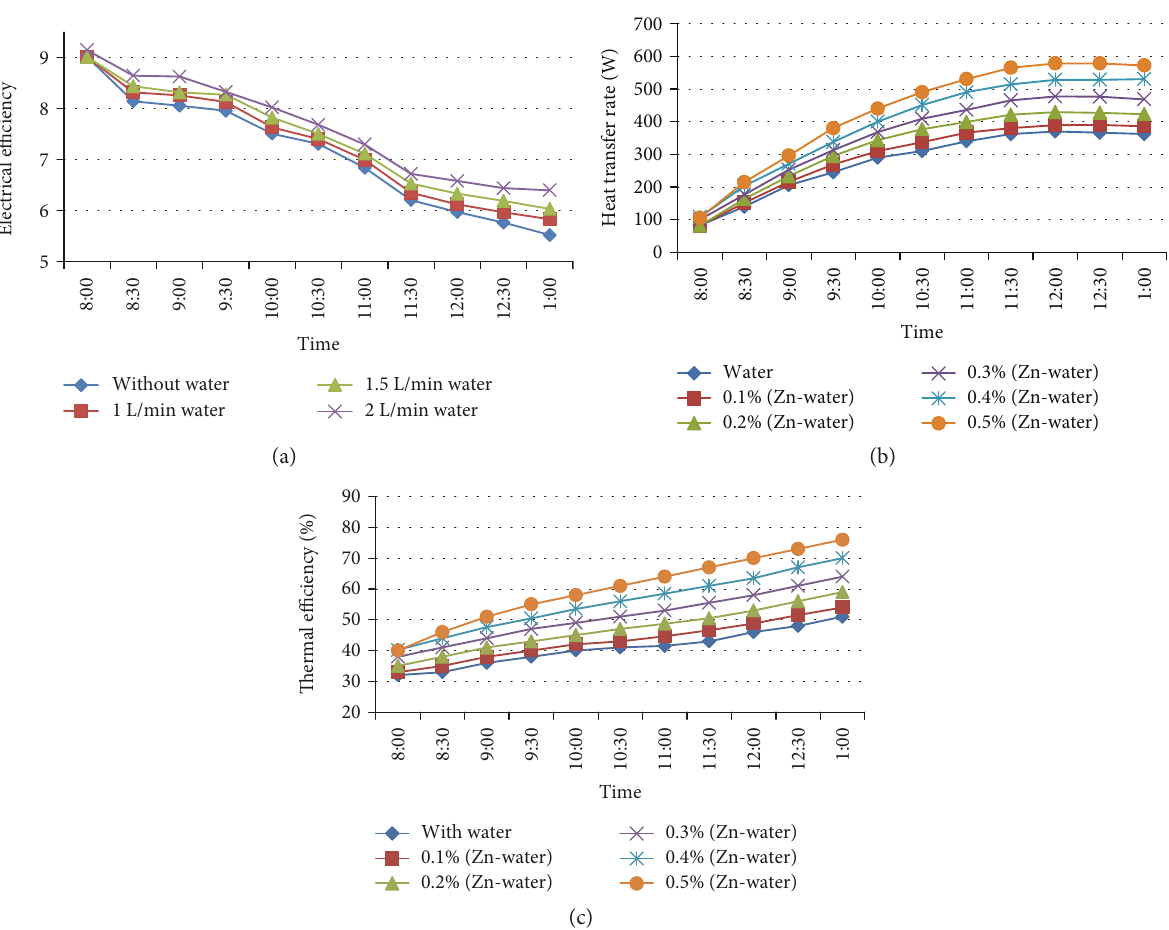
Figure 8: (a) E ff ect of mass fl ow rates on the electrical e ffi ciency. (b) Heat transfer rate at constant fl ow rate (2 L/min) at di ff erent nano fl uid O nano fl uid at 2L/min on thermal e ffi concentrations. (c) E ff ect of Zn-H 2